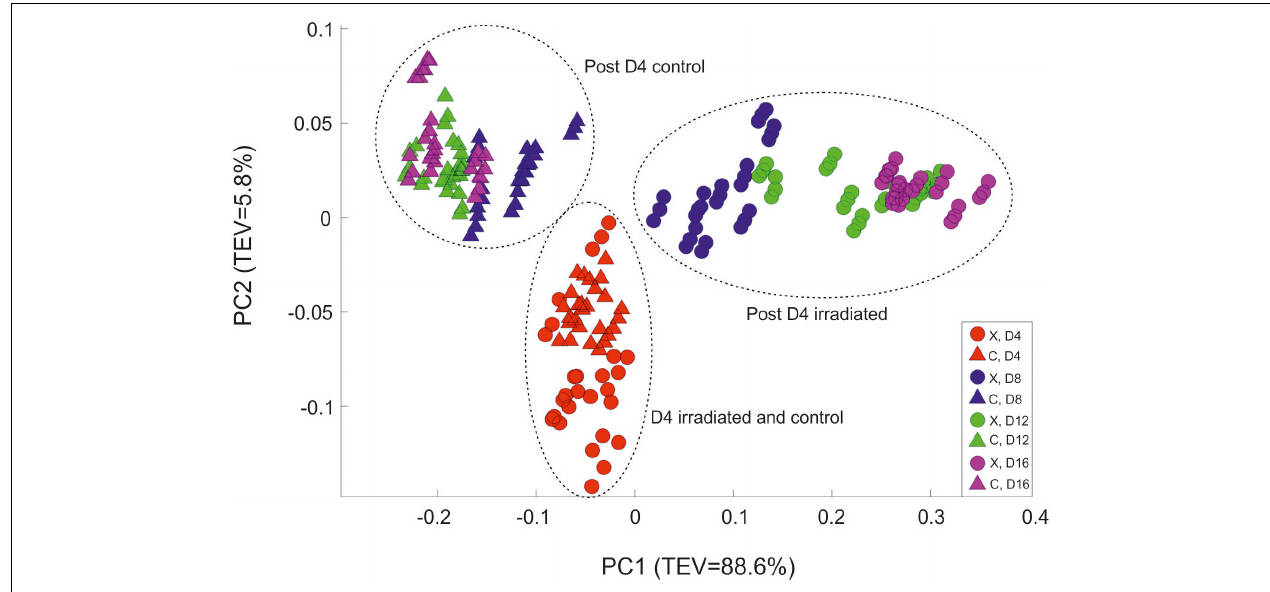
FIGURE 2 | Principal component analysis scores plot of all the FT-IR spectroscopy data. Circles represent the irradiated (X) samples; triangles are control (C) samples. Color code: Red- day 4; Blue- day 8; Green- day 12; and Purple day 16. TEV = Total Explained Variance.